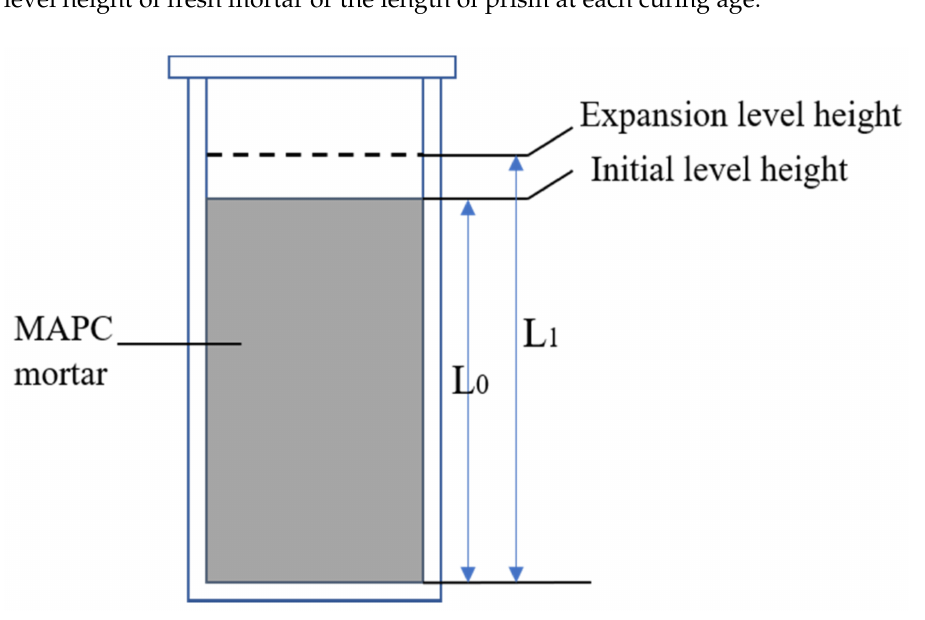
Figure 1. Testing apparatus of linear expansion of fresh MAPC mortar before